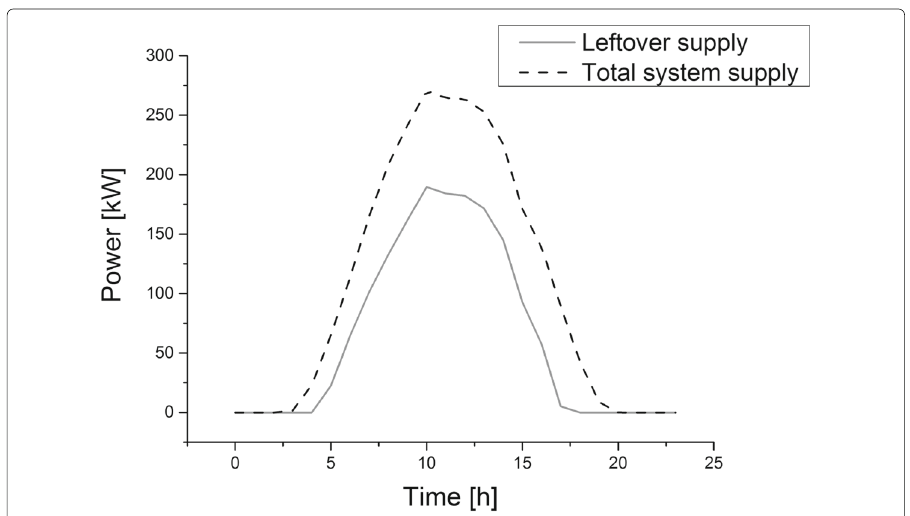
Fig. 6 Total supply in the system and leftover supply (after self-consumption by prosumers) - Solar rooftop production only